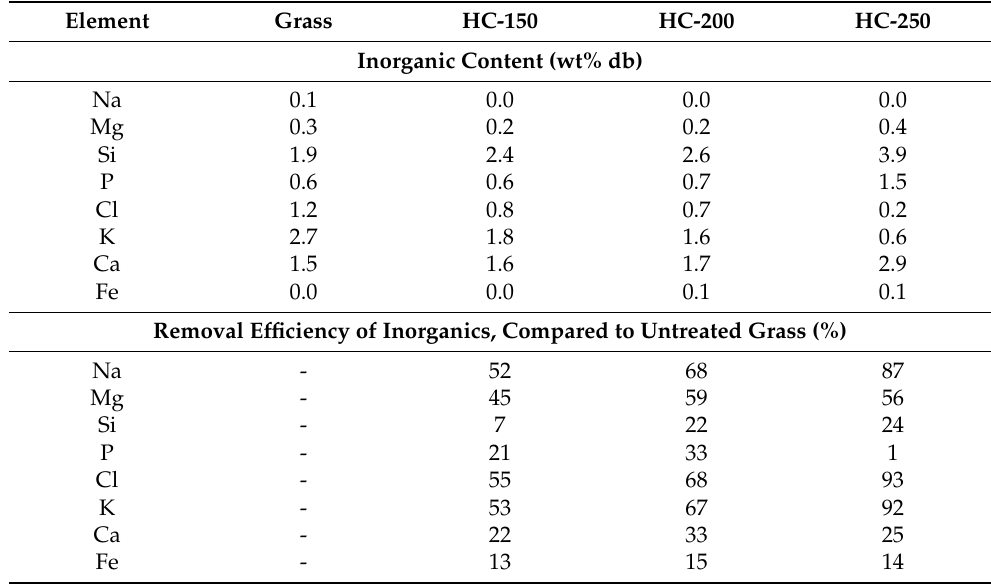
Table 3. Inorganic composition of grass and hydrochars, alongside the removal efficiencies of inorganic species from hydrochars, compared to the original